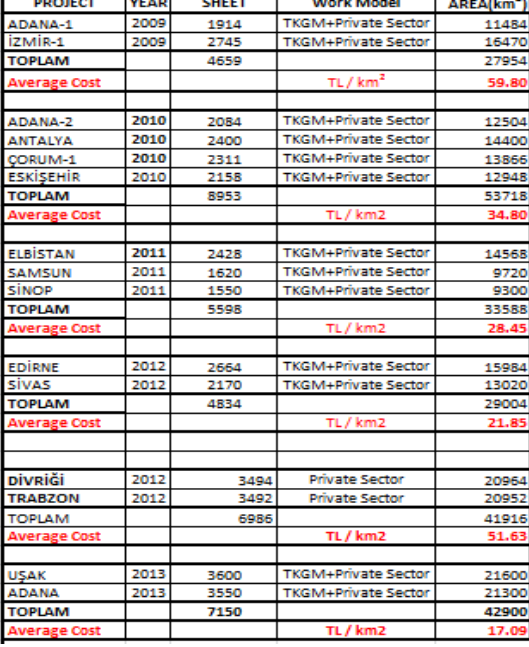
Table 1. Average procurement cost